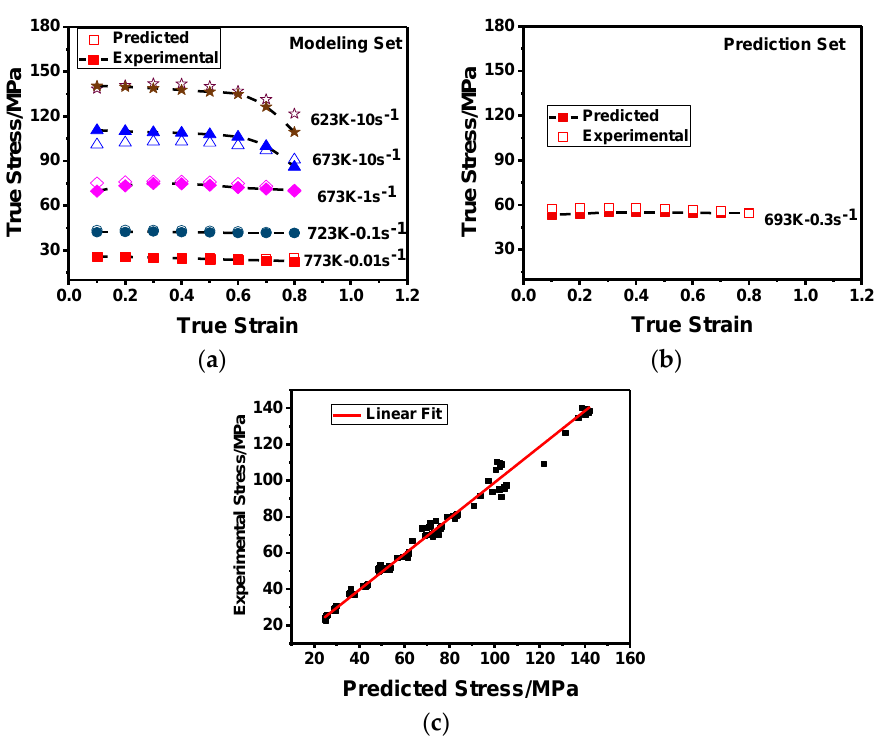
Figure 8. Correlations between the experimental and predicted flow stresses of the physically based constitutive model: ( a ) under modeling set; ( b ) under prediction set; ( c ) by linear fit.